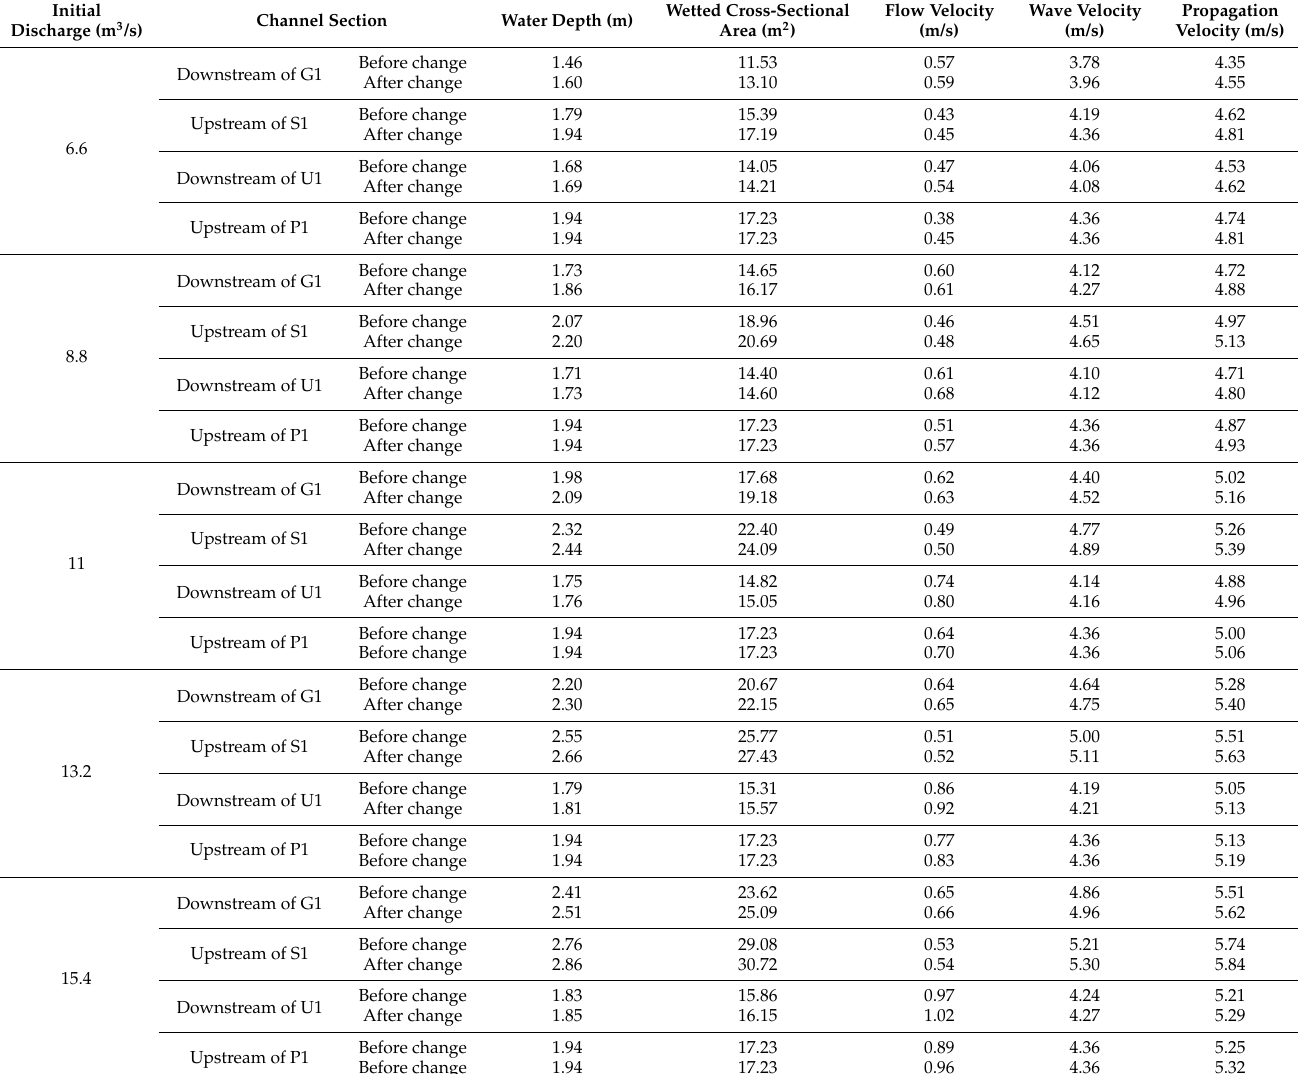
Table 2. Hydraulic parameters under different initial